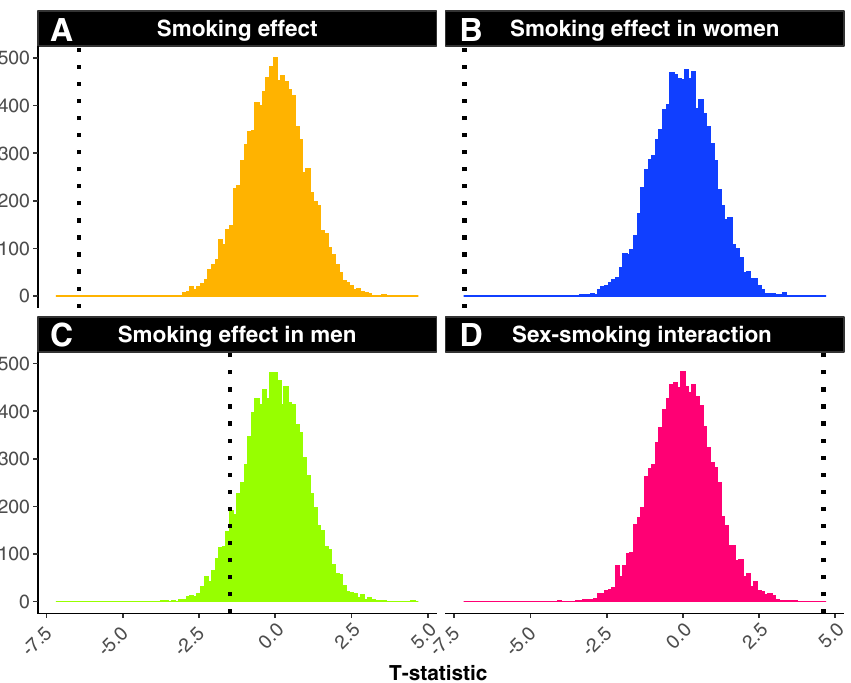
Figure 8. We examined the smoking effect on PAL through the use of permutation testing. This was performed one million times per model. The smoking data label for every participant was randomly assigned and the t-statistic for the main effect of smoking in the whole cohort ( A ), women only ( B ), and men only was re-calculated ( C ). We also conducted permutation tests on the interaction between sex × smoking on PAL ( D ). Black dashed line indicates the full model results statistic. Results from permutation testing indicate the present results are likely not due to